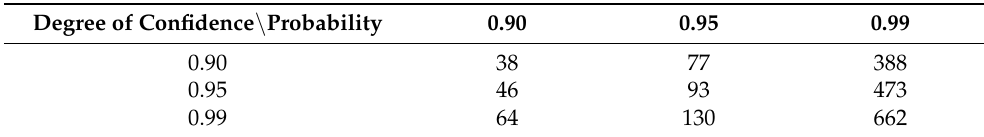
Table 1. Degree of confidence, probability, and sample size.